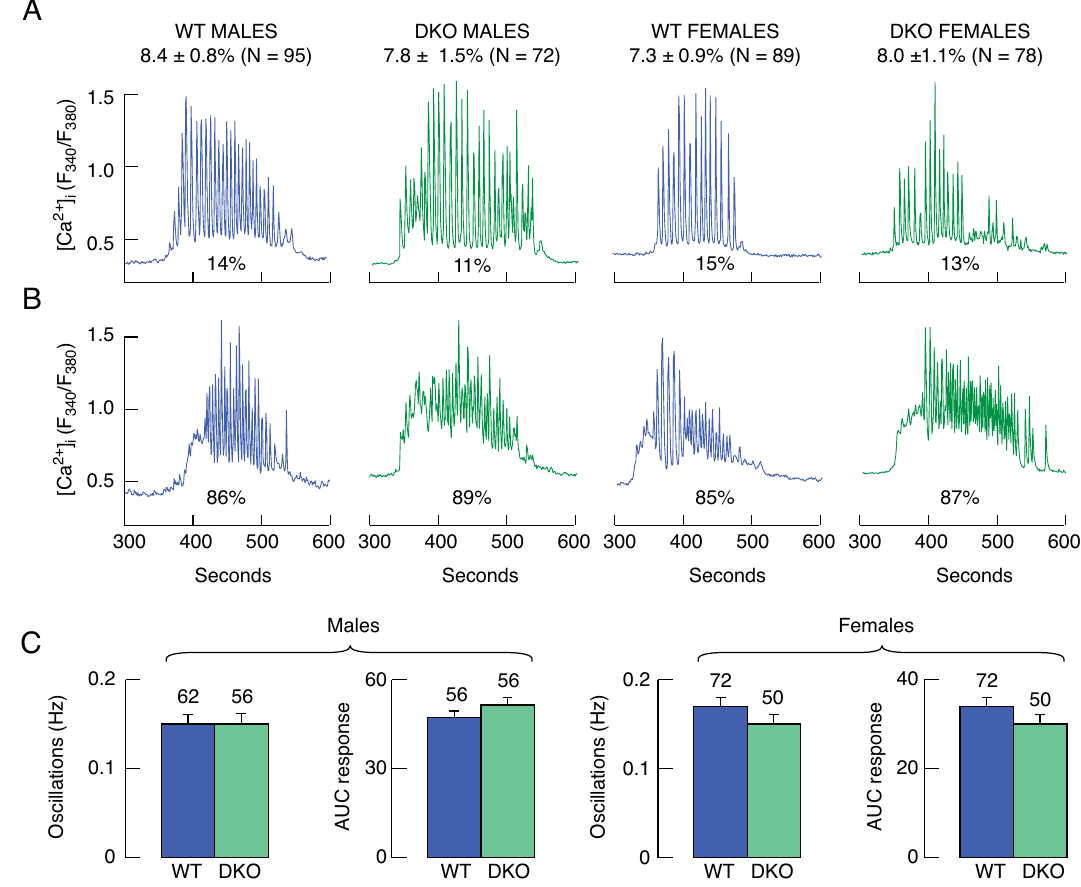
Figure 5. GnRH (100 pM) induced calcium signaling in cultured pituitary cells. Dissociated pituitary cells were cultured for two days, washed, and calcium recording was done in Fura-2 loaded single cells during the first 5 min in the absence of GnRH (not shown), followed by 3 min application of 100 pM GnRH and washout of GnRH for 2 min. Experiments were performed with cells derived from WT and DKO male and female mice. The averaged percentage of responding cells is shown above traces as mean ± SEM values. N indicate total number of cells responding to GnRH with the threshold calcium signaling. ( A ) A smaller fraction of cells responded to GnRH with more regular calcium oscillations. ( B ) The majority of cells responded with damped oscillations. ( C ) Quantification of intracellular calcium response to GnRH in gonadotrophs from WT and DKO males and females: frequency of spiking and the area under the curve (AUC) of the calcium able to conclude that decreased GnRH synthesis reflects down-regulation of Gnrh1 and Kiss1 gene expression in DKO males and females, causing a decrease in Lhb expression and LHB synthesis in pituitary gonadotrophs. We also analyzed the cell distribution and number of hypothalamic GnRH neurons WT and DKO females and males using immunohistochemistry. DKO did not alter GnRH cell body distribution nor had a visible effect on GnRH cell body number in males (Fig. 7A,B) and females (Fig. 7C,D; representative neurons are indicated by arrows). However, there was an apparent reduction in GnRH immunoreactivity throughout the arcuate nucleus that GnRH fibers cross to reach the median eminence (indicated by arrows in Fig. 7E–H) in DKO animals compared to WT males (Fig. 7E,F) and WT females (Fig. 7G,H). In contrast, the GnRH fiber density project- ing to organum vasculosum laminae terminalis did not appear different between DKOs and WTs (Fig. 7A–D). Quantification analysis confirmed no significant changes in the number of GnRH neurons in DKO females and males (Fig. 7I) but a significant decrease of GnRH fiber density in the arcuate nuclei of males (Fig. 7J) and females (Fig. 7K) DKOs were detected. These results suggest that the decrease in Gnrh1 expression and/or GnRH secre- tion might account for decrease in Lhb expression and LH synthesis in both females and males. The kisspeptin immunoreactivity in hypothalamic tissues of WT and DKO animals was also analyzed. As indicated by red arrows in Fig. 8, kisspeptin immunoreactivity was detected in the rostral periventricular region of the third ventricle (RP3V) (Fig. 8A–D) and the arcuate nucleus (Fig. 8E–H). As expected, moderate immuno- reactivity in RP3V was detected in both WT (Fig. 8A) and DKO male animals (Fig. 8B). However, immunoreac- tive kisspeptin fibers were dense in the RP3V of WT female animals (Fig. 8C) but undetectable in DKO animals despite that kisspeptinergic cell bodies were visible in DKO animals (Fig. 8D). Immunoreactive kisspeptin fibers were dense in the arcuate nucleus of WT males and females (Fig. 8E,G), but barely discernable in the arcuate nucleus of DKO males and females (Fig. 8F,H). Quantification of kisspeptinergic cell bodies in the RP3V region